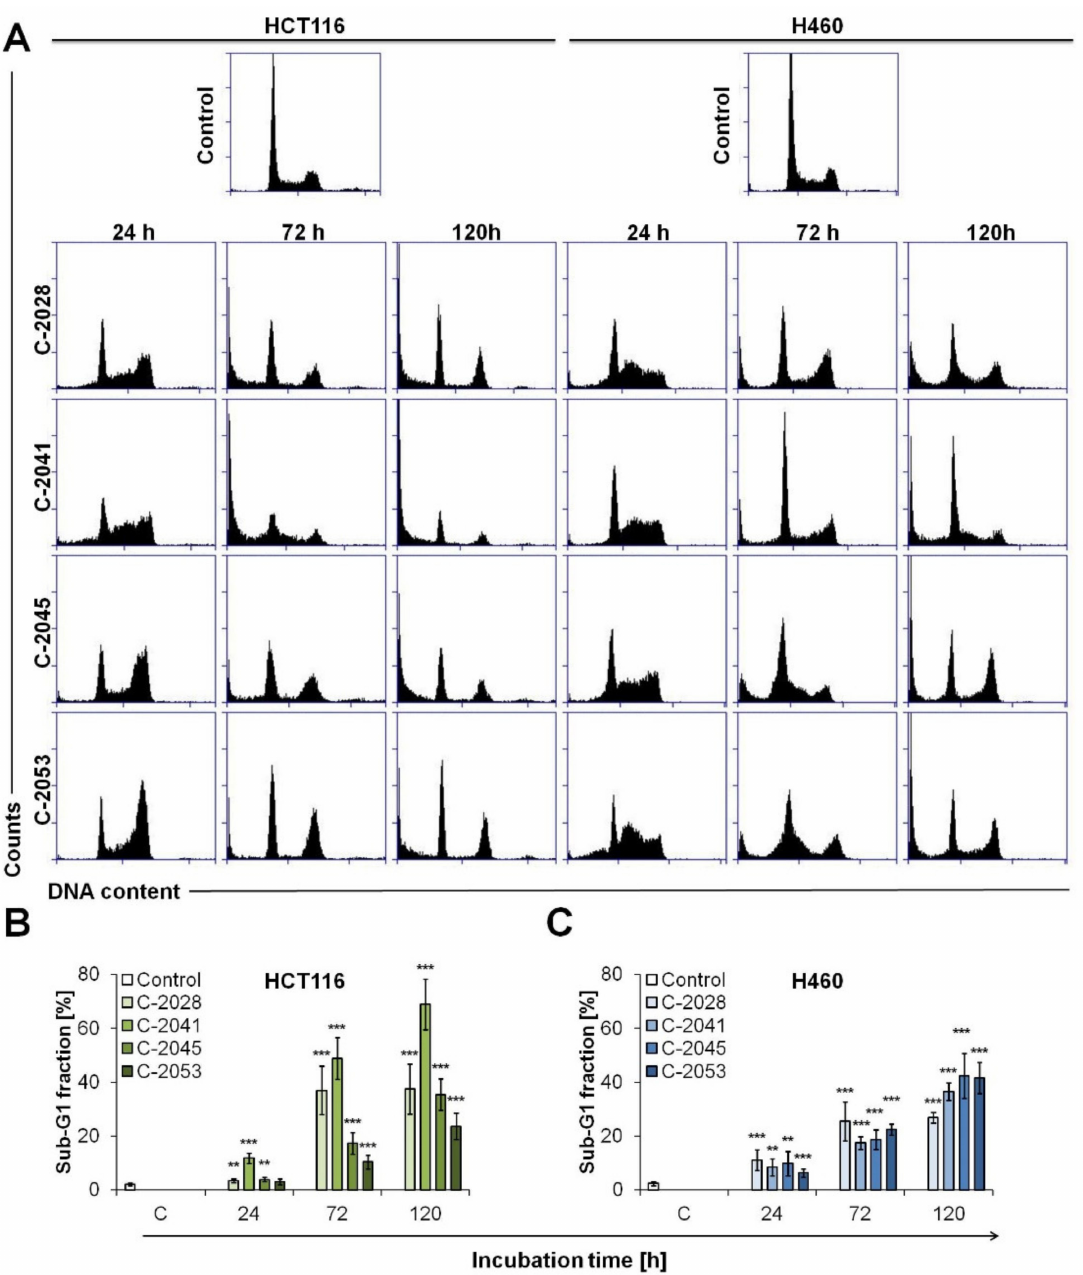
Figure 4. Cell cycle distribution of cancer, HCT116 and H460 cells. Cells were untreated (control) or treated with 0.04, 0.05, 0.4 and 0.2 µ M of C-2028, C-2041, C-2045 and C-2053 compounds, respectively, for the times indicated and subjected to propidium iodide staining and flow cytometry analysis, as described in Materials and Methods. ( A ) Histograms show the number of cells ( y -axis) versus DNA content ( x -axis) and are representative of at least three experiments for each condition. Bar graphs show quantified data, expressed as the percentages of HCT116 ( B ) and H460 ( C ) cells with less than 2N DNA (sub-G1 fraction). Significantly different from the control at: * p < 0.05; ** p < 0.01; *** p < 0.001; ( n ≥